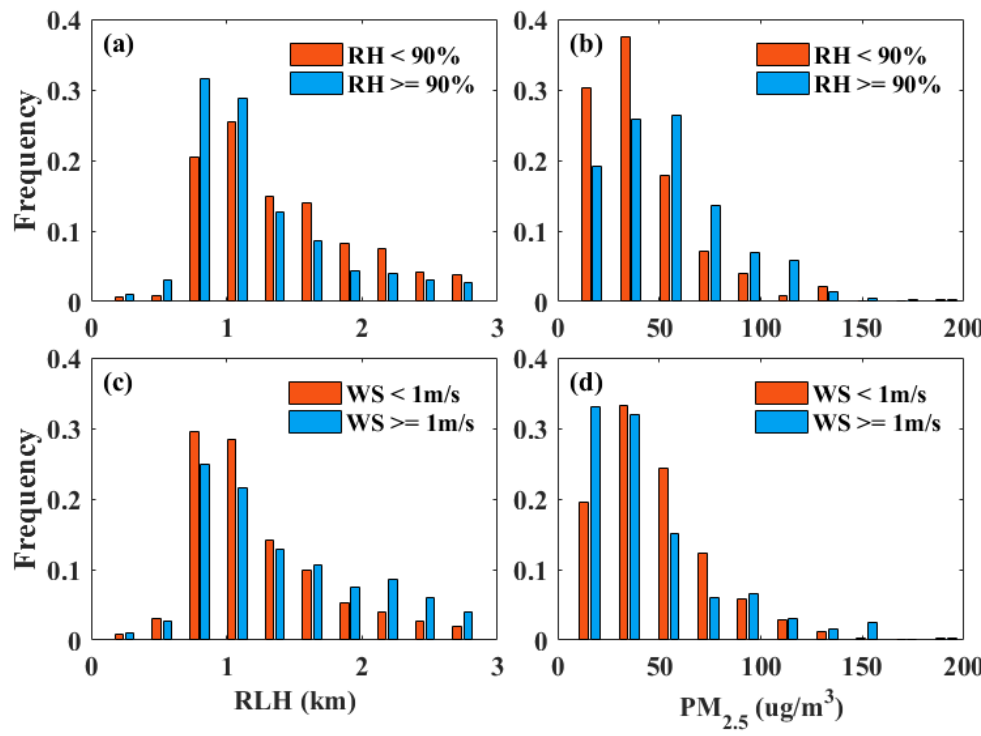
Figure 6. Frequency distribution of RLHs under different ( a ) RH, and ( c ) WS conditions. Frequency distribution of PM 2.5 concentrations under different ( b ) RH, and ( d ) WS conditions.